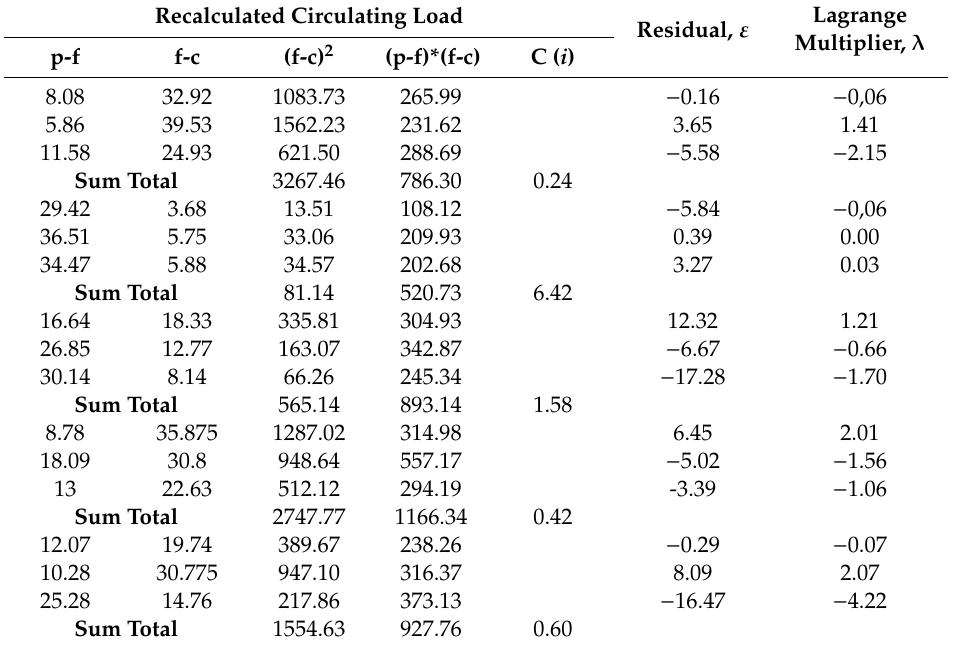
Table A2. Calculation of